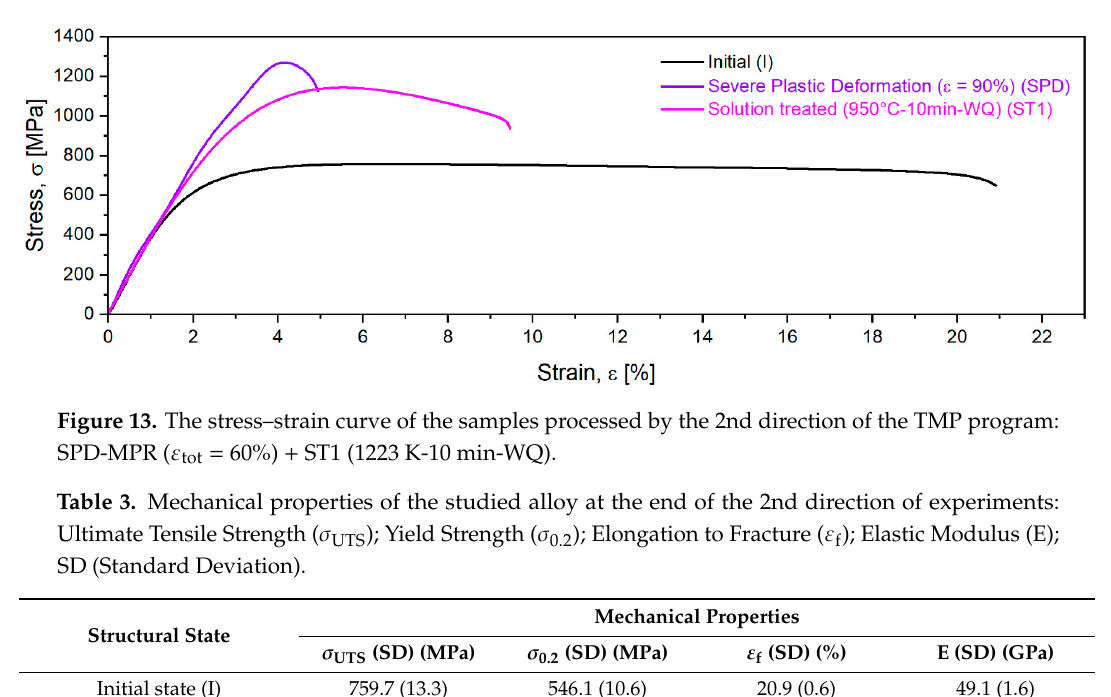
Figure 12. The SEM images of the two samples corresponding to the 2nd direction of the TMP Program: ( a ) SPD-MPR ( ε tot = 60%) + ST1 (1223 K-10 min-w.q.); ( b ) SPD-MPR ( ε tot = 60%) + ST2 (1223 K-20 min-w.q.).